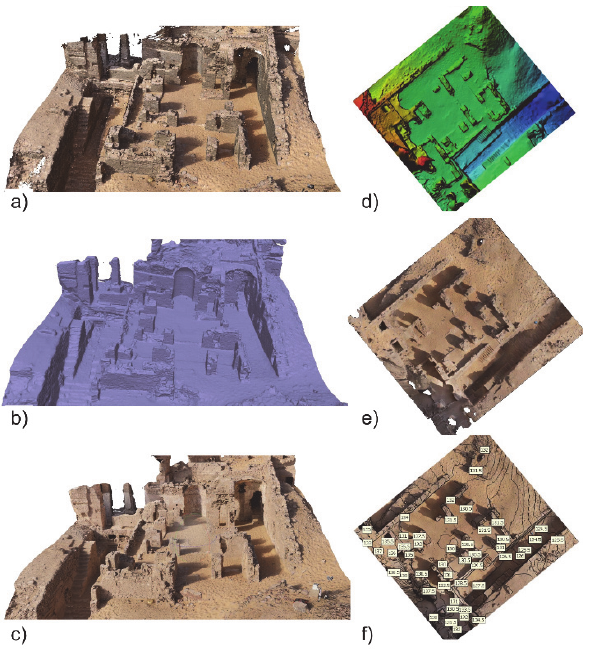
Figure 5. Examples of the photogrammetric process performed using PhotoScan: a) point cloud; b) 3D mesh; c) 3D model with real texture; d) ground DEM; e) ground orthoimage; f) contour lines.